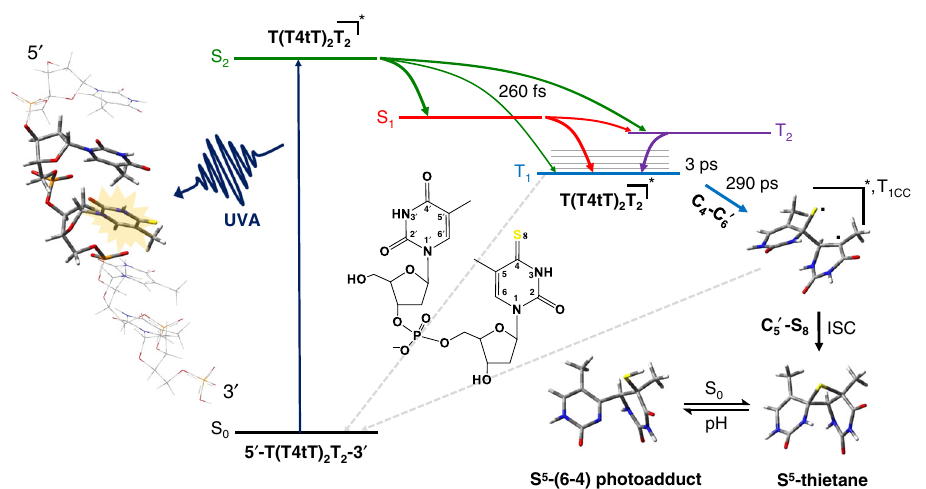
Fig. 6 Proposed mechanism for the formation of the DNA (6 – 4) photoadduct in PBS at pH 7.4. The colored arrows represent electronic transitions. A 4tT base is highlighted with light orange in the single-stranded DNA sequence depicted to the left to imply that 4tT bases are selectively photoactivated by the UVA radiation. 4tT and the thymidine 5 ′ relative to the 4tT are represented as tube in the single-stranded DNA sequence, while the other nucleobases are depicted as wireframe in order to highlight the importance of having a thymine 5 ′ relative to the 4tT for the reaction to occur. In the chemical structures yellow, red, blue, gray, and white, represent sulfur, oxygen, nitrogen, carbon, and hydrogen,